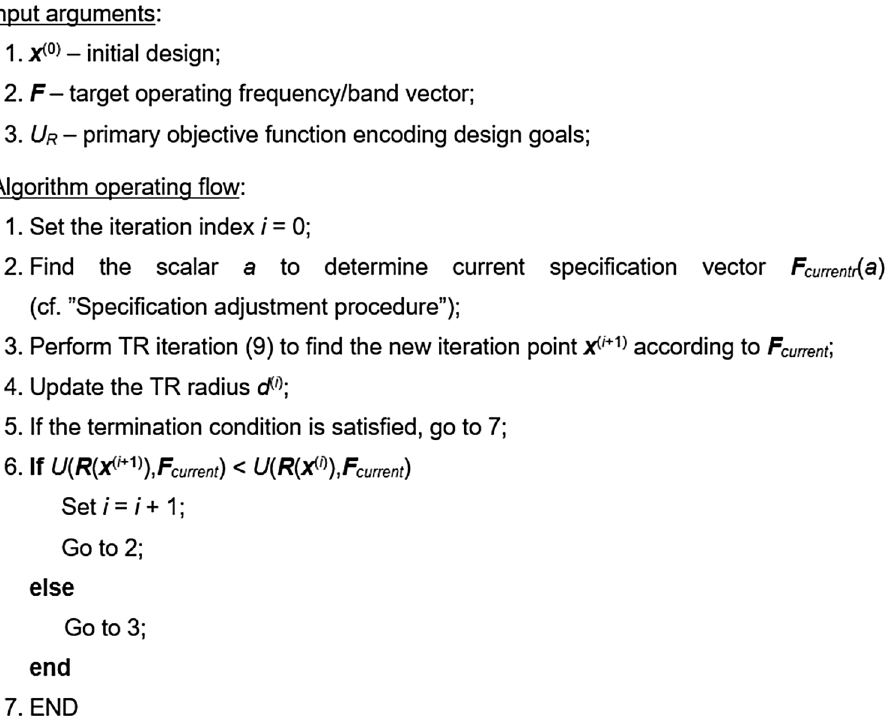
Figure 3. Pseudocode of the trust-region algorithm with design specification management scheme through intelligent decision-making of “Specification adjustment